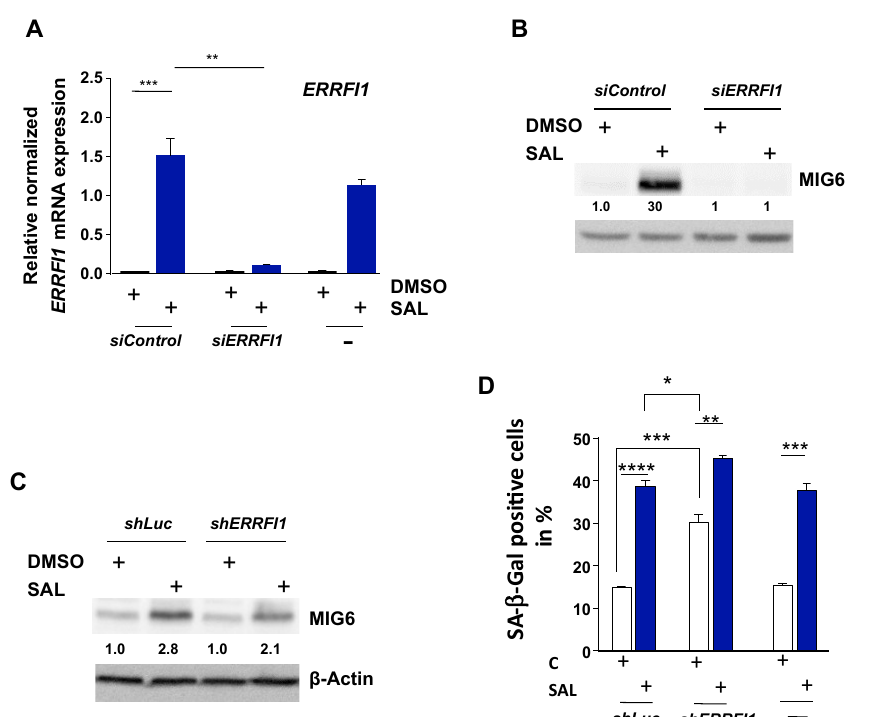
Figure 5. Knockdown of ERRFI1 significantly decreases ERRFI1 mRNA and protein expression. LNCaP cells were treated for 72 h with SAL or DMSO as solvent control. RNA and proteins were extracted and analyzed by ( A ) qRT-PCR and Western blotting ( B , C ), respectively. ( B ) The ERRFI1 mRNA expression was normalized to the housekeeper mRNAs TBP and GAPDH . The mean and SEM values were calculated from 3 biological replicates. The protein levels of MIG6 upon si-mediated knockdown ( B ) or sh-mediated knockdown ( C ) were normalized to the loading control β -Actin using LabImage 1D software (Kapelan Bio Imaging solutions, Leipzig, Germany, Version L340). Numbers indicate a fold-change of protein expression. ( D ) Knockdown of ERRFI1 induces cellular senescence. The percentage of the SA- β -Gal positive LNCaP cells was calculated in relation to total number of cells per observed field of each transfection and treatment. Two random fields per well were counted, and the mean was calculated.